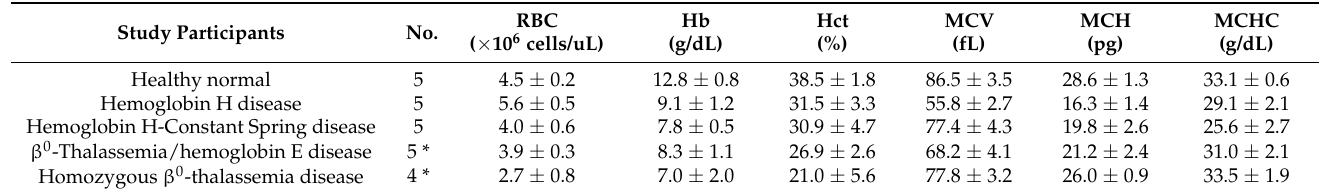
Table 1. Red blood cell parameters in thalassemia patient and healthy normal